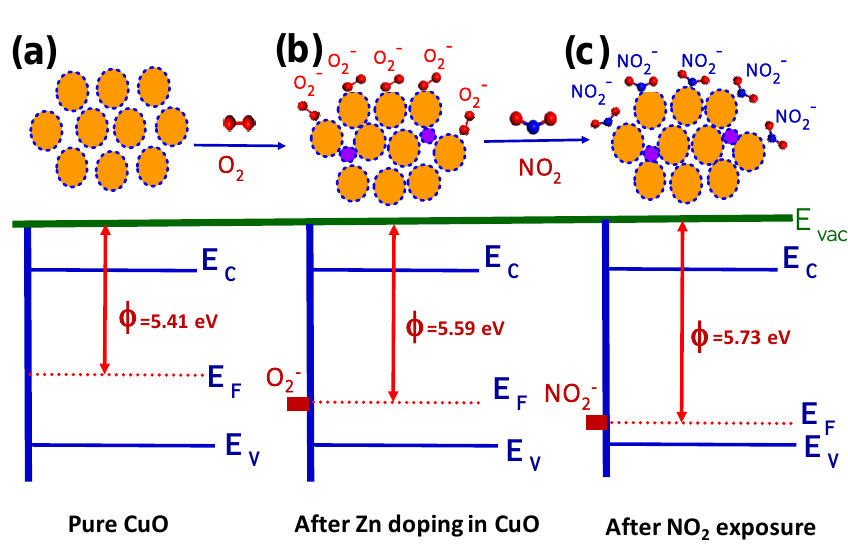
Figure 15. Schematic representation of the NO 2 sensing mechanism; work function of ( a ) pure CuO, and changes after ( b ) Zn doping and ( c ) NO 2 exposure.